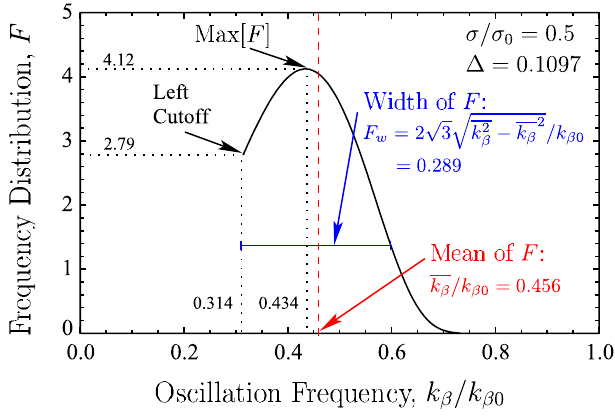
FIG. 8. Quantities listed in Table IV illustrated for